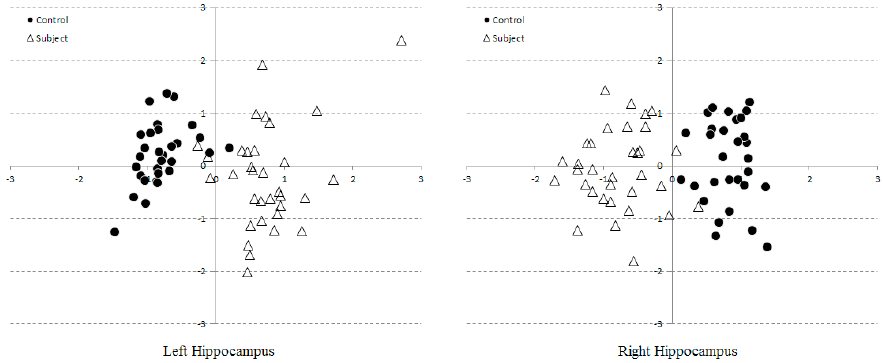
Figure 6. Scatter plots of two model parameters consensually extracted from 63 hippocampi.